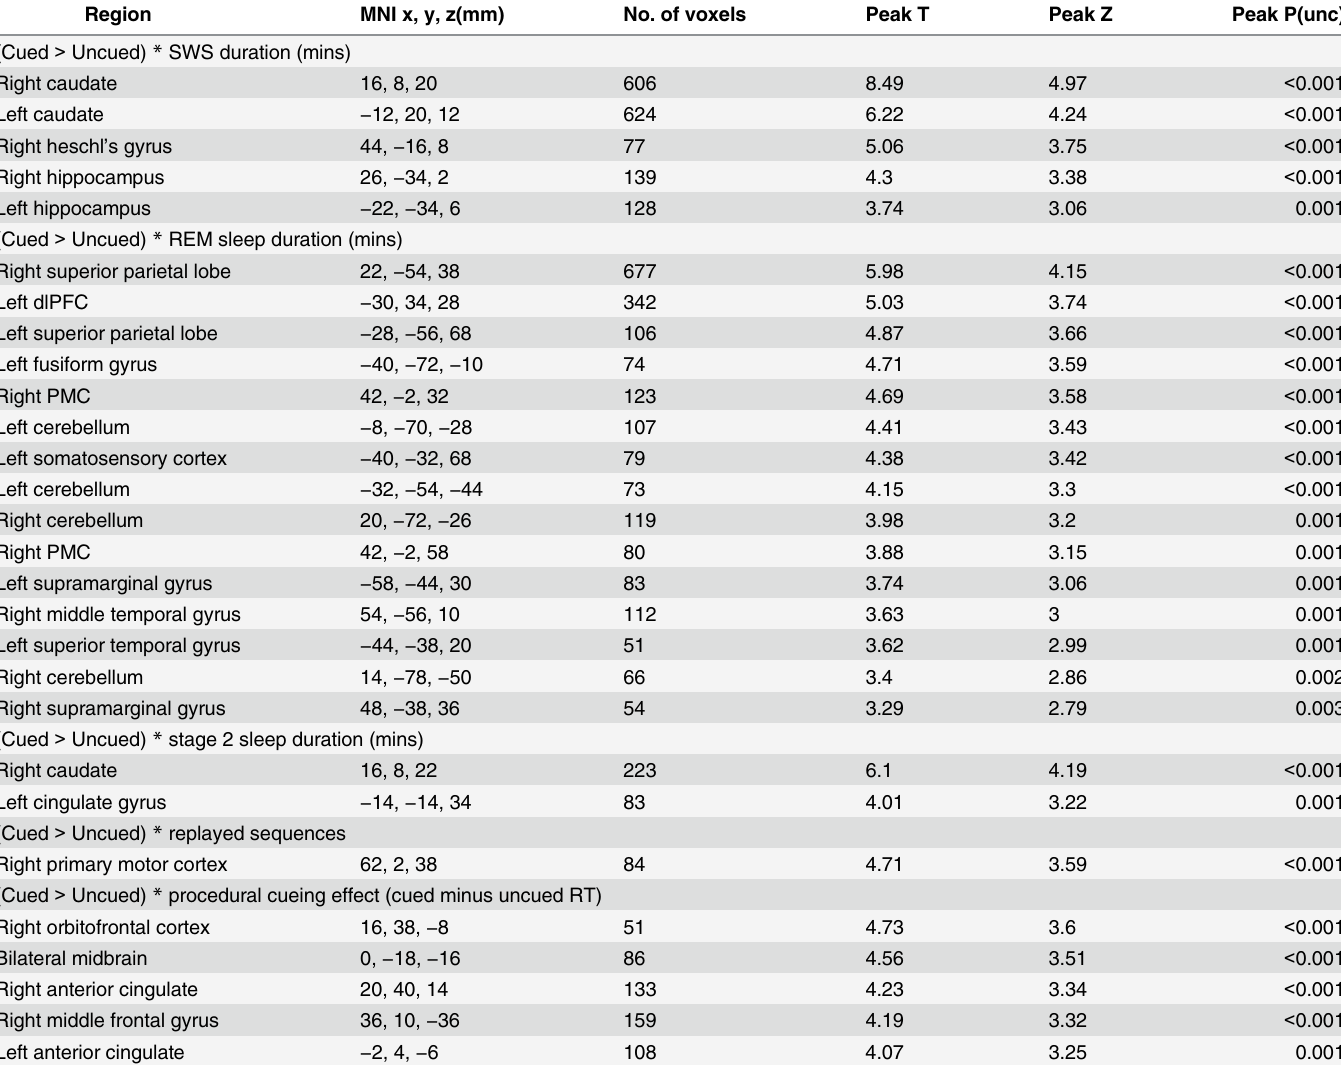
Table 3. Coordinates of local maxima for brain regions showing greater activity for the cued relative to the uncued sequence ( n = 20), when consid- ering covariates of SWS, REM, stage 2, replays, and the procedural cueing effect. Region MNI x, y, z(mm) No. of voxels Peak T Peak